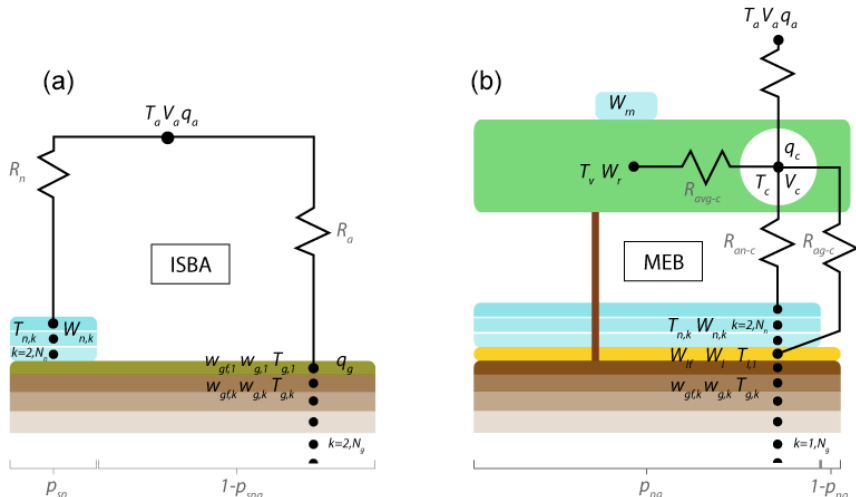
Figure 1. Schematics of ISBA (a) and MEB (b) during a snow period on a forest